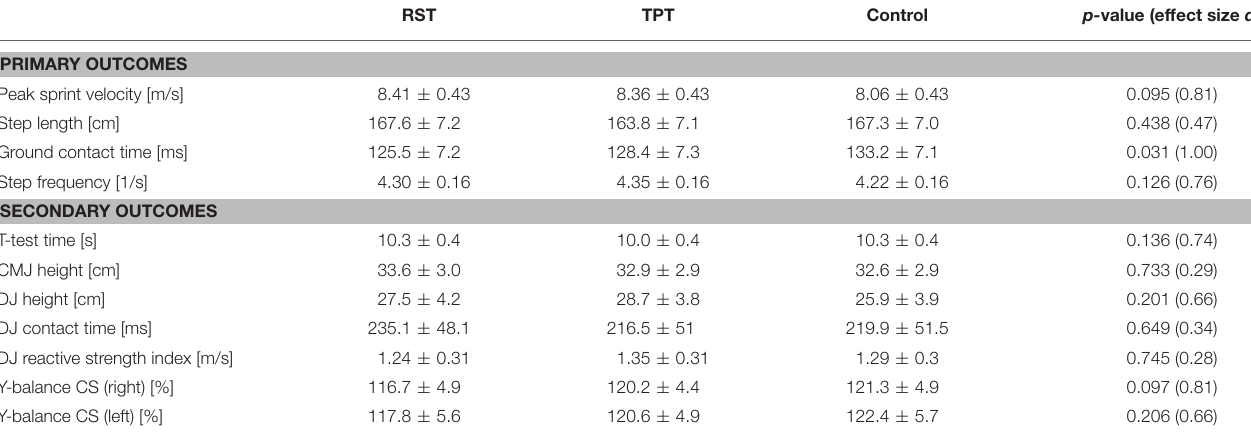
TABLE 4 | Primary and secondary outcome measures at post-test for the resisted sprint training (RST) group, traditional power training (TPT) group, and control group. RST TPT Control p- value (effect size d )